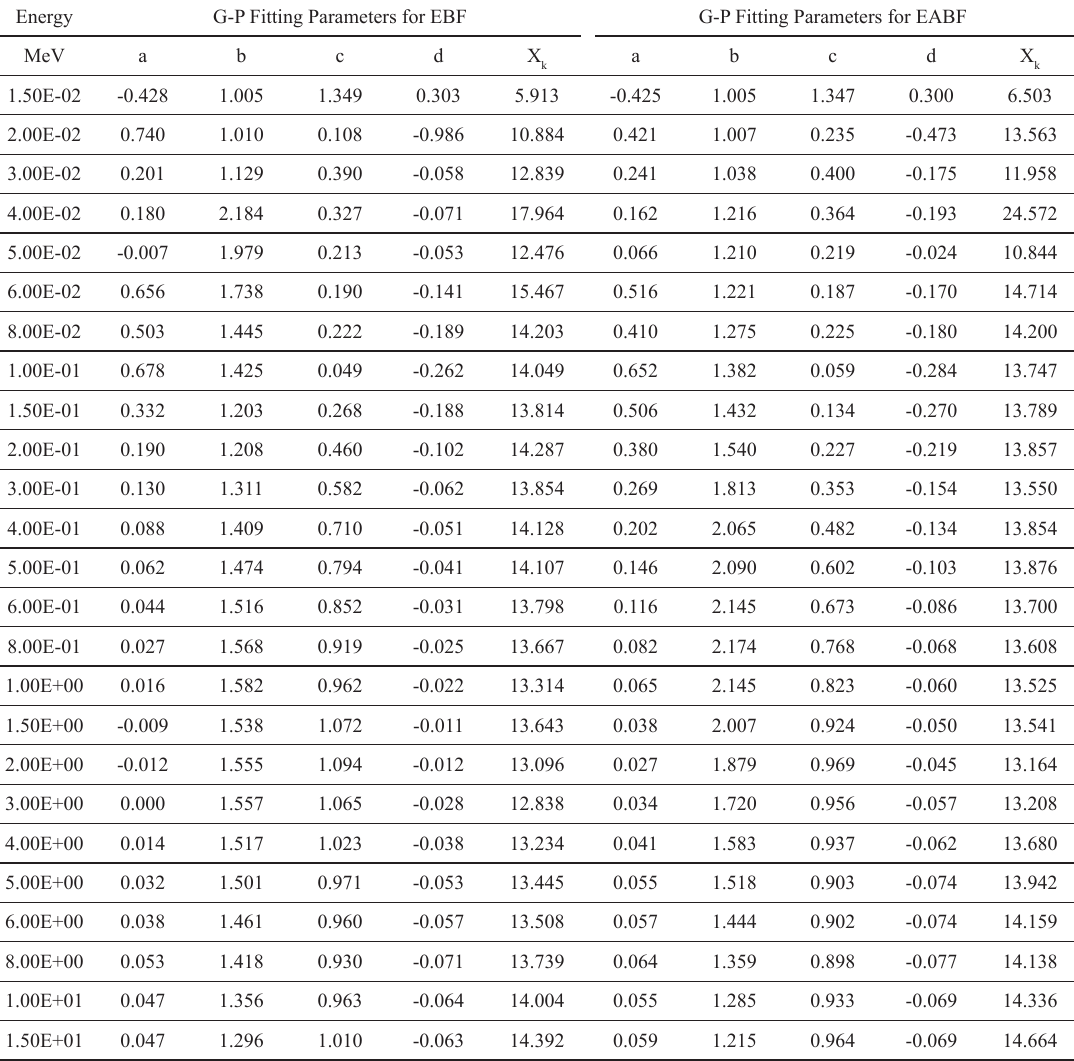
Table 5. GP fitting parameters for EBF and EABF in the case of ZBiB-8 (as an example) in the energy range of 0.015-15 MeV. Energy G-P Fitting Parameters for EBF G-P Fitting Parameters for EABF